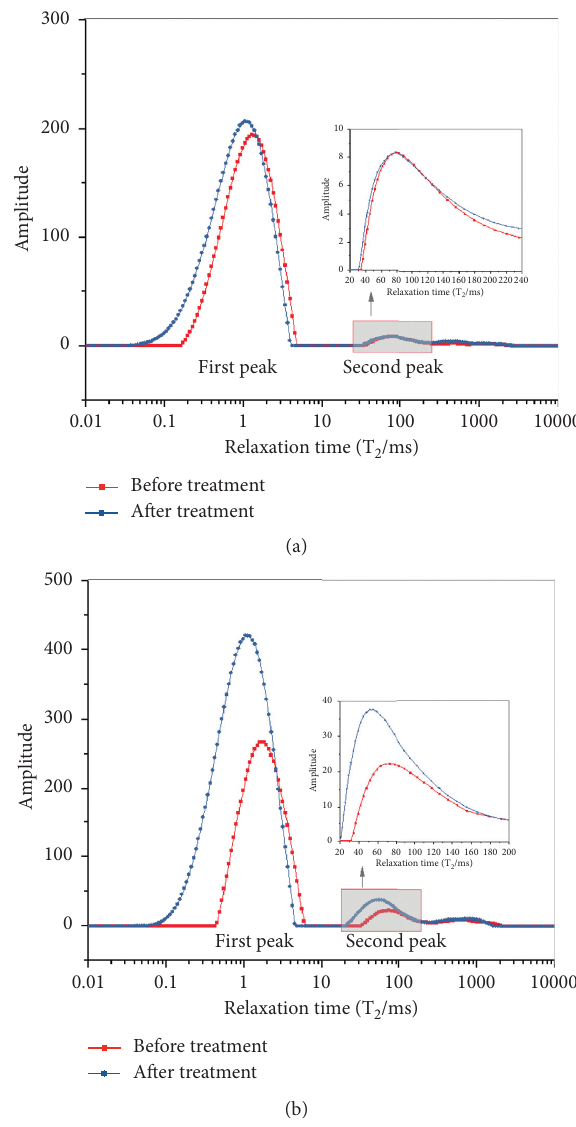
Figure 5: NMR T2 distribution. (a) Dry coal sample. (b) Saturated coal sample.